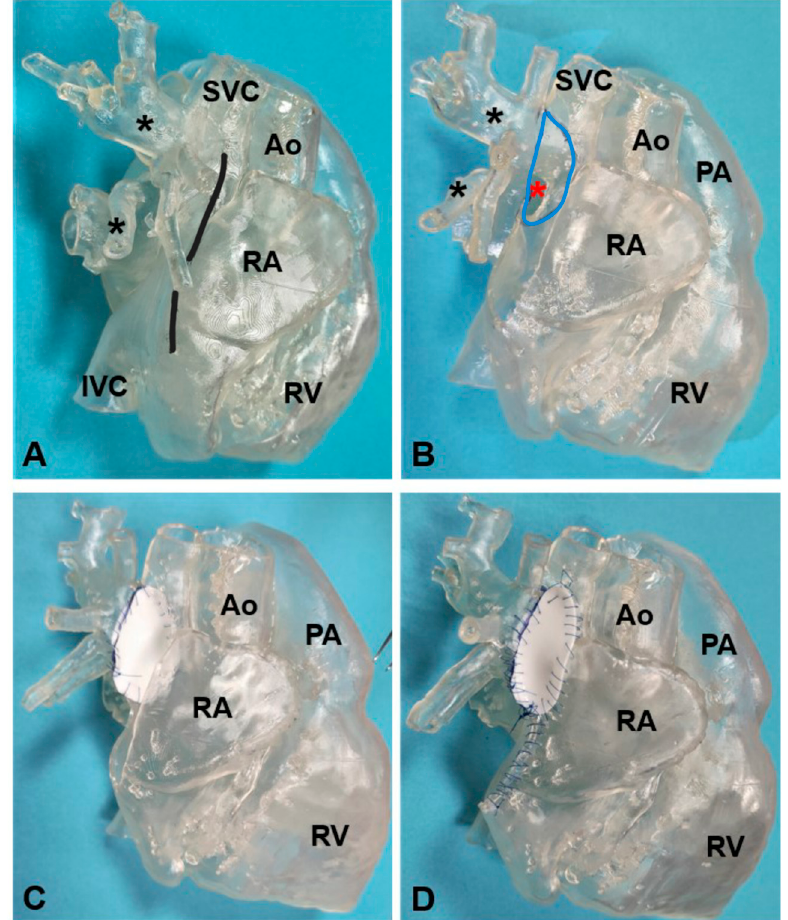
Figure 6. The 3D-printed model of a partial anomalous venous return (highlighted by black asterisks) corrected using the double patch technique. ( A ) An atriotomy is first performed as shown by the black line in the model; ( B ) the superior sinus venosus defect is now visible (highlighted by the red asterisk) through the superior half pf the right atriotomy (highlighted by the light blue line); ( C ) the first patch is sutured to baffle the pulmonary veins’ drainage through the sinus venosus defect and into the left atrium; ( D ) the second patch is used to enlarge the superior vena cava to avoid blood flow obstruction. Ao: aorta; IVC: inferior vena cava; PA: pulmonary artery; RA: right atrium; RV: right ventricle; SVC: superior vena cava.